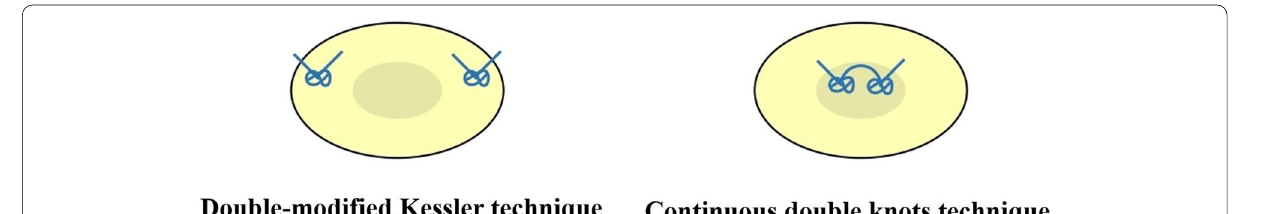
Fig. 2 Showing the continuous double knots technique